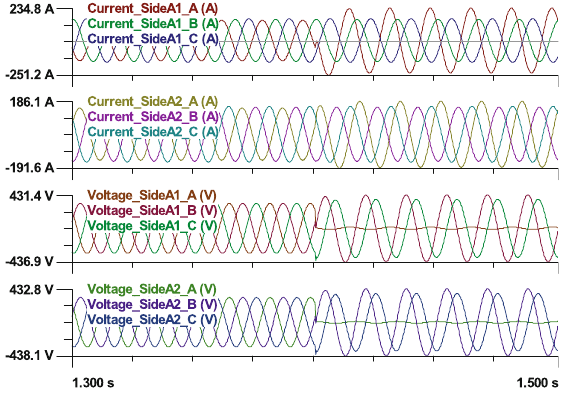
Fig. 16 Three phase currents and voltages of event 4: internal bolted fault, islanded mode